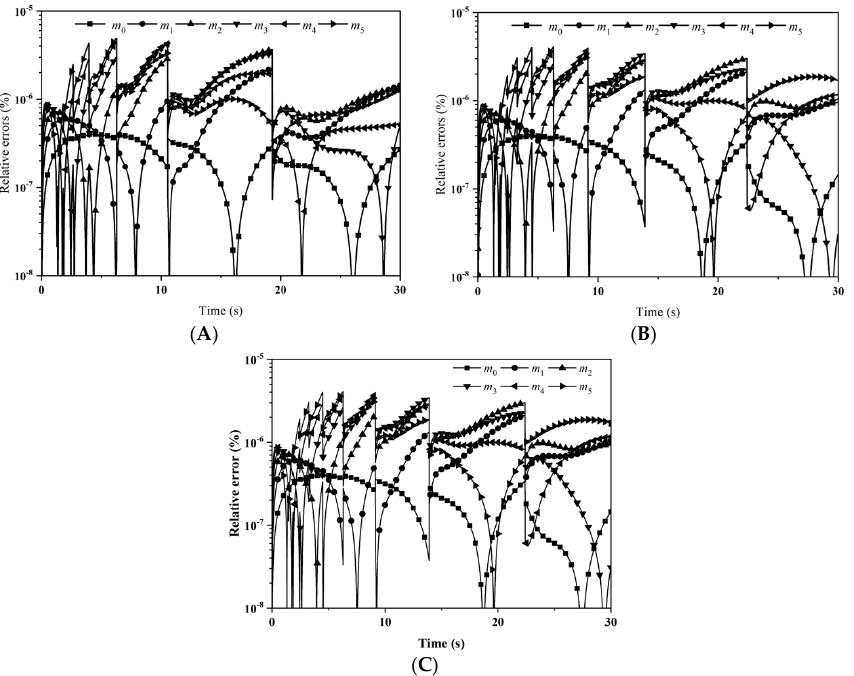
Figure 7. Evolution of the percentage errors for the first six moments with: ( A ) LFPQMOM; ( B ) QMOM; and ( C ) FPQMOM for the pure aggregation with sum kernel and exponential initial PSD (square: m 0 ; circle: m 1 ; up triangle: m 2 ; down triangle: m 3 ; left triangle: m 4 ; right triangle: m 5 ).